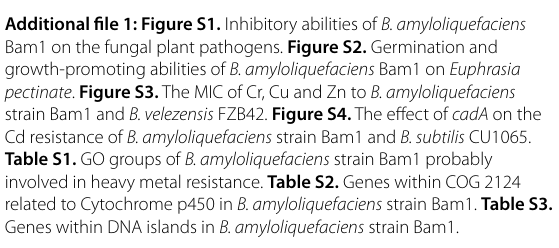
Table S1. GO groups of B. amyloliquefaciens strain Bam1 probably involved in heavy metal resistance. Table S2. Genes within COG